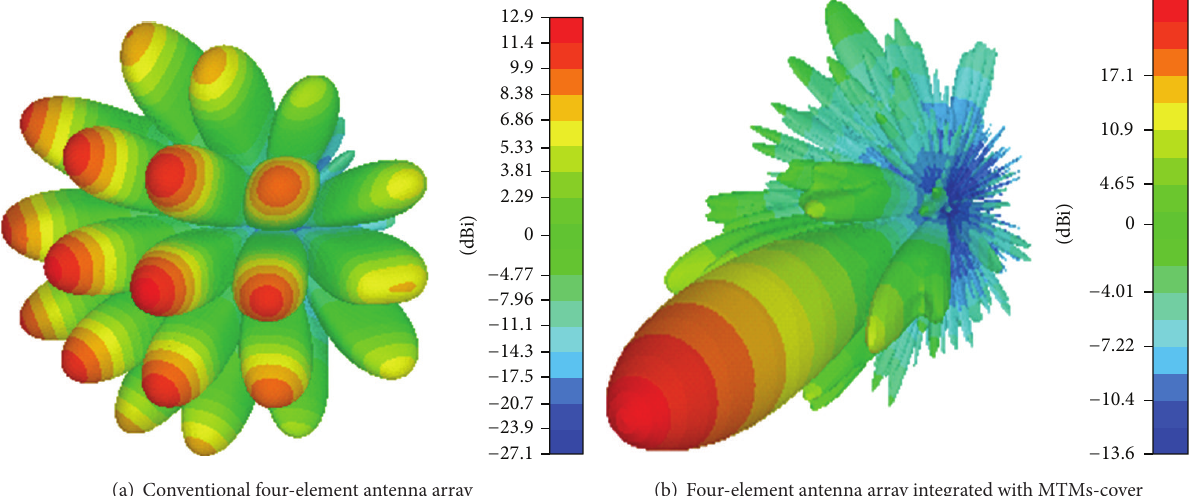
Figure 4: Three-dimensional radiation patterns of MTMs-cover array and the conventional type: (a) conventional 2 × 2 element antenna array; (b) 2 × 2 element antenna array with